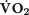
Dependence of total oxygen consumption (V˙O2), V˙O2 related to proton leak, V˙O2 related to ATP synthesis, Δp, NADH (% of total NAD) and phenomenological ATP/O2 ratio on relative activity of ATP usage (relative rate constant, kUT, or its activation in relation to rest, AUT) in skeletal muscle for ‘standard’ proton leak activity.